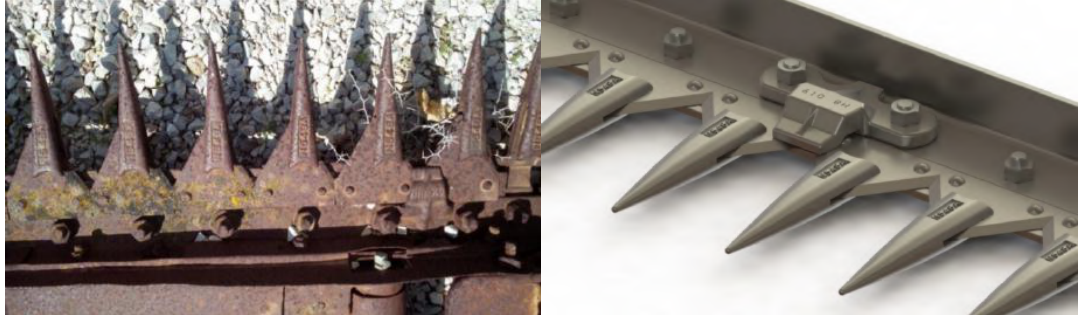
Figure 4. Cutting system with tines and blades ( left ) and its computer-aided design (CAD) three- dimensional (3D) model ( right